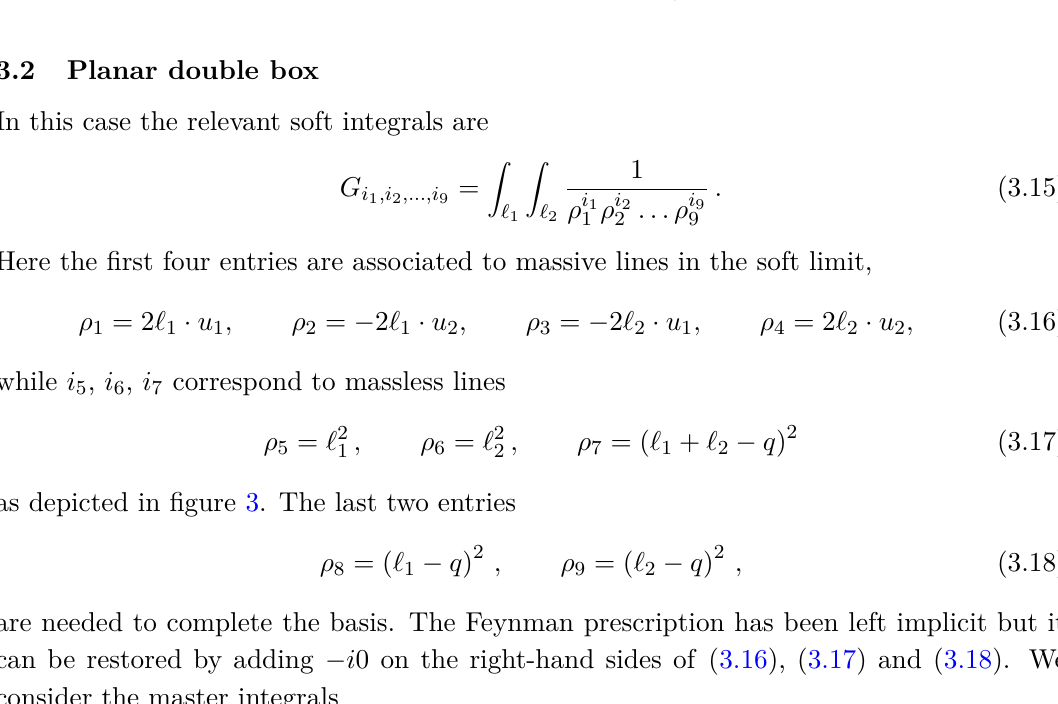
Figure 3. The double box